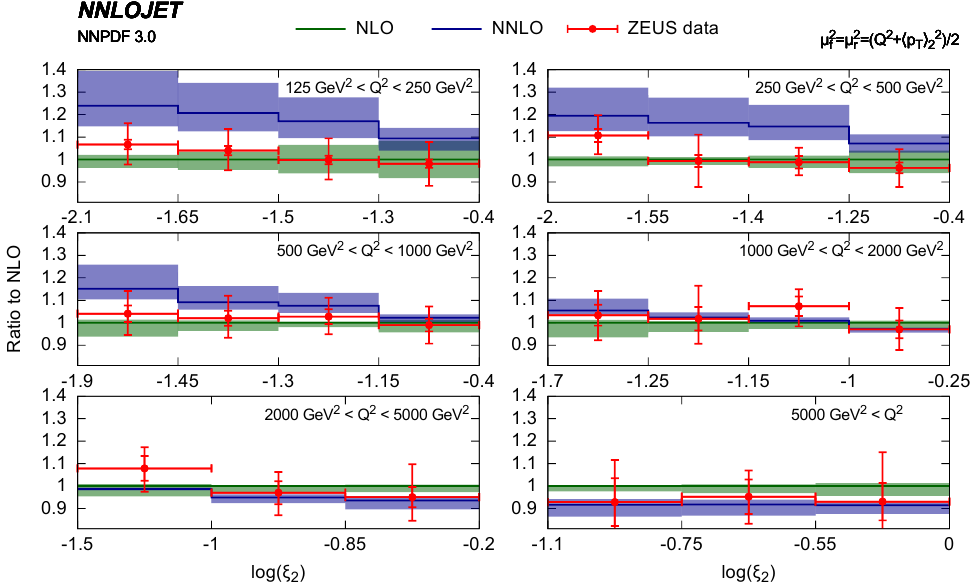
Figure 12 . Inclusive di-jet production cross section as a function of log( (cid:24) ) in bins of Q 2 , compared to ZEUS data.